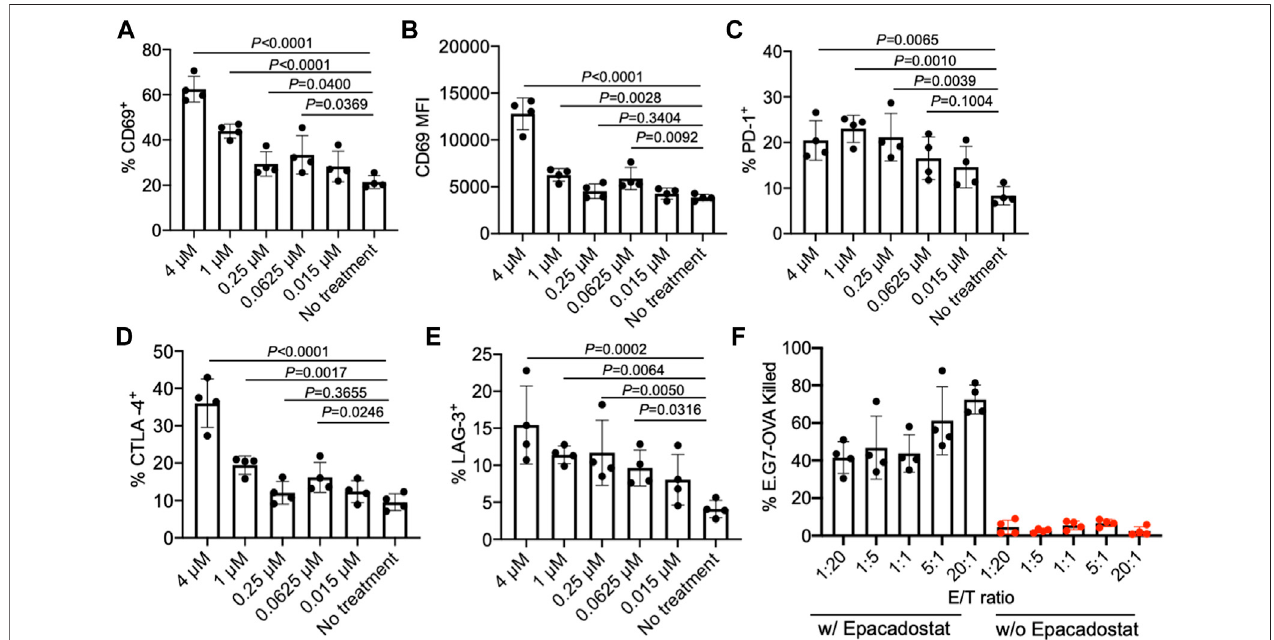
FIGURE3| IDO1inhibitor,epacadostat,canactivateCD8 + Tcellsandimprovekillingoftumorcells. (A) Percentageand (B) MFIofCD69 + OT1cellsaftertreatment with different concentrations of epacadostat for 16 h. Also shown are the percentages of (C) PD-1 + , (D) CTLA-4 + , and (E) LAG-3 + OT1 cells after treatment with epacadostat for16 h. (F) PercentageofkilledE.G7-OVA cellsbyOT1cellsat differentE/Tratios within24 hinthepresenceorabsenceofepacadostat pretreatment.All the numerical data are presented as mean ± SD (0.01 < * p ≤ 0.05; ** p ≤ 0.01; *** p ≤ 0.001).